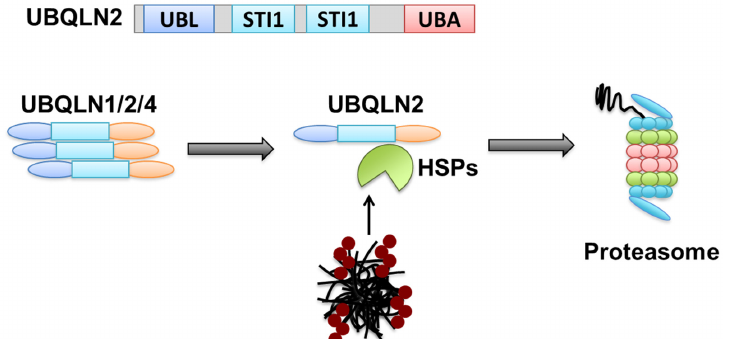
Figure 4. UBQLN2 functions in both proteasome and autophagy degradation pathways depending on its status. When UBQLN is held in homo or heterooligomers, it could target and mediate autophagy substrates. Under stress conditions, UBQLN2 is released and acts as a proteasome receptor for misfolded proteins disassembled by HSP70/HSP110 chaper- ones.